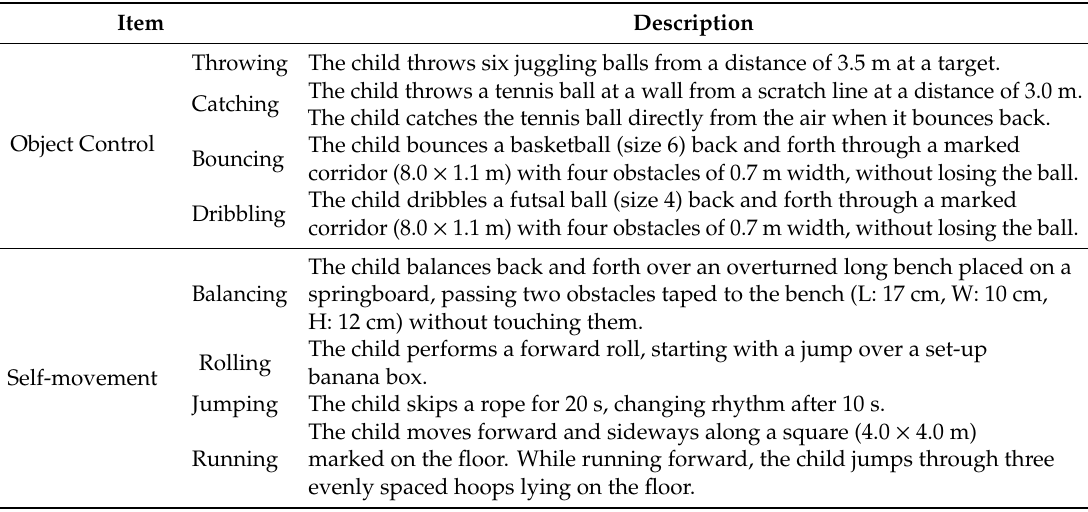
Table 1. Description of the Motoriche Basiskompetenzen (MOBAK) 5-6 test